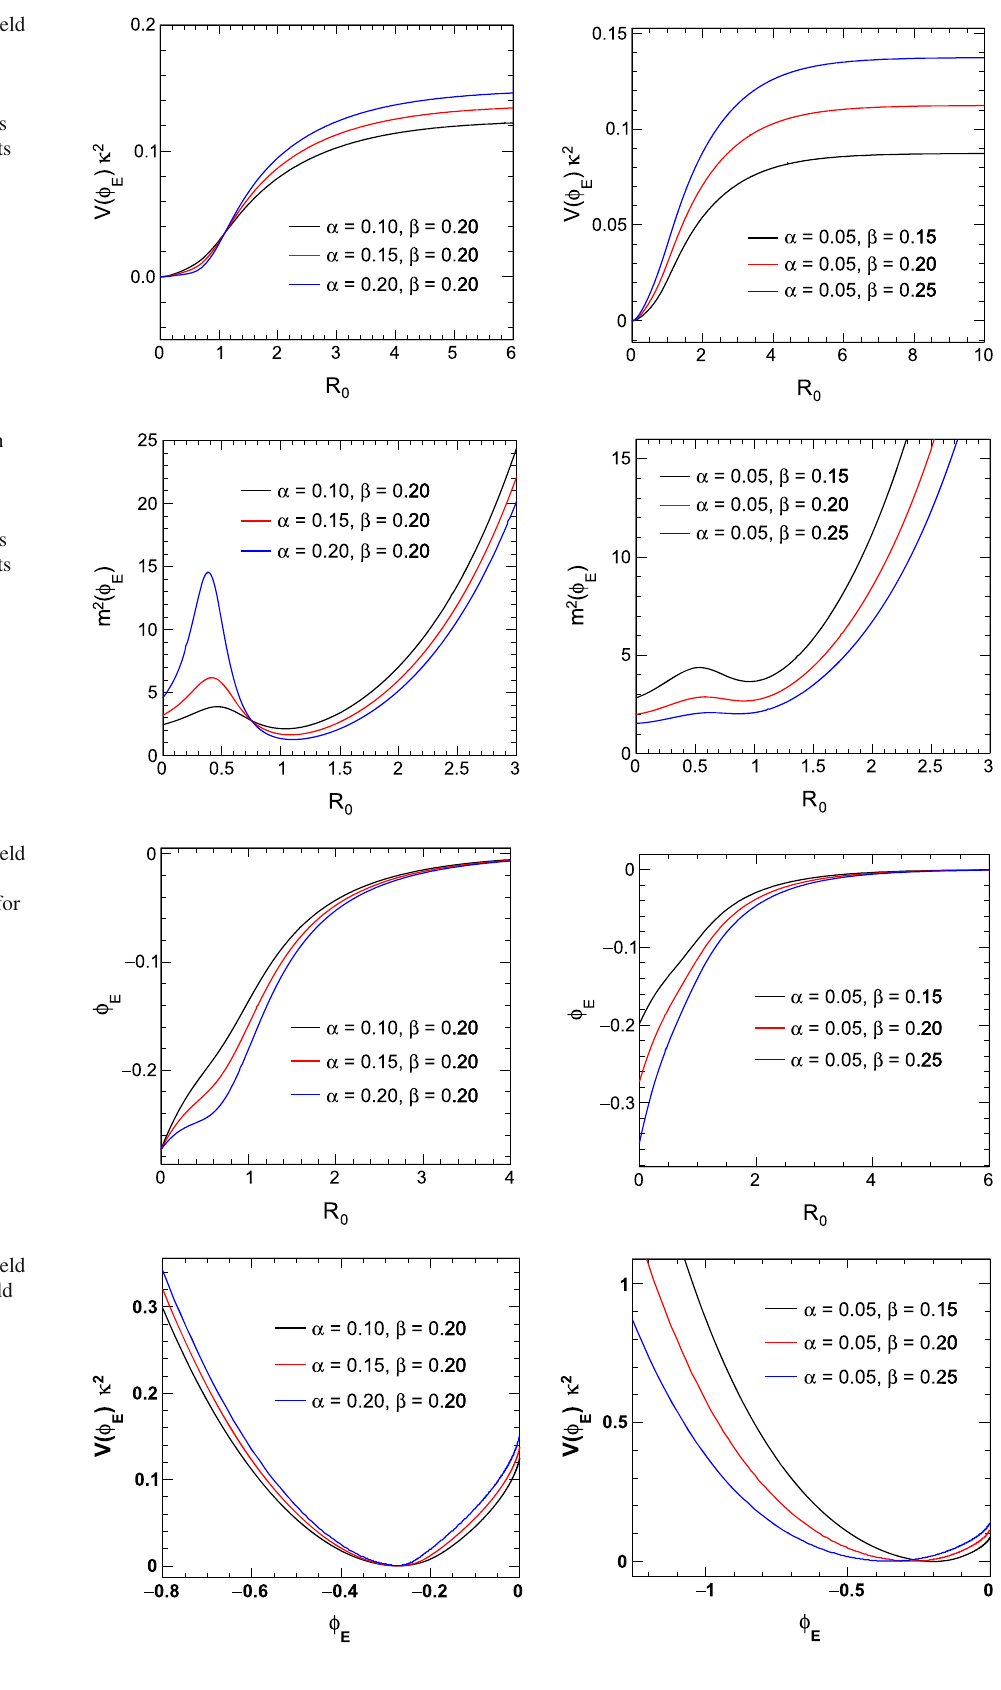
Fig. 6 Variation of scalar field potential as a function of field φ E in Einstein frame for different values of α and β parameters with R c = 1 in arbitrary